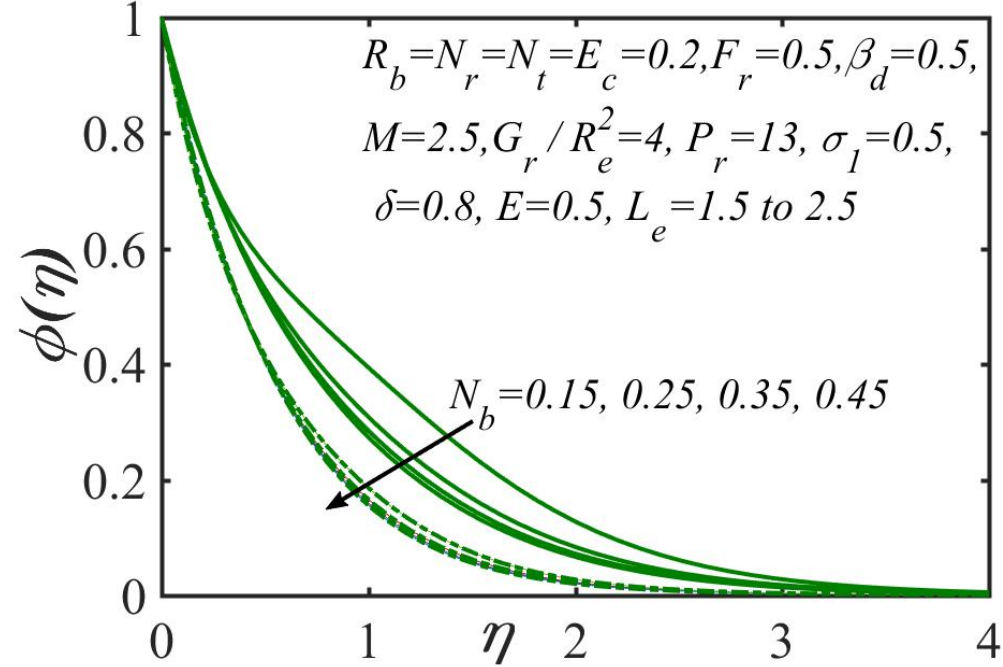
Figure 11. Influence of the Brownian-motion parameter N b and the bio-convection Lewis number “ L e ” on concentration distribution. Solid line: L e = 1.5, Dotted line: L e = 2.5.